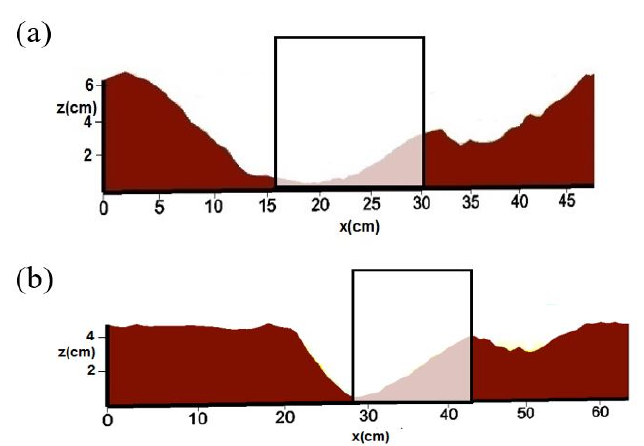
Figure 2. Profile of the scour hole after the equilibrium state was achieved ( a ) without vegetation and ( b ) with vegetation.